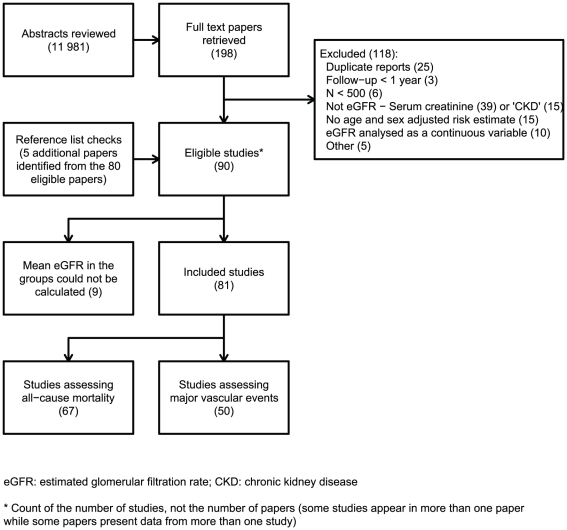
Results of the literature search.